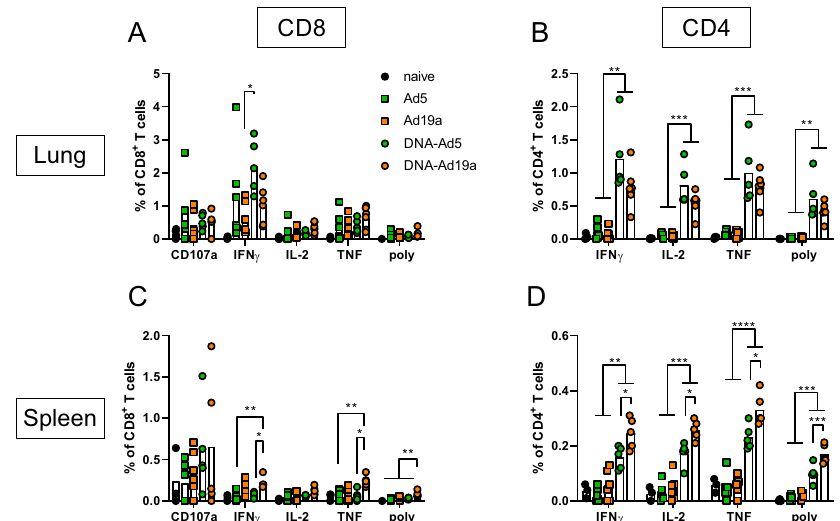
Fig. 4 Spike-speci fi c T cell responses after intranasal immunization with Ad5- or Ad19a-based viral vector vaccines. BALB/c mice were vaccinated according to Fig. 1A. Lung and spleen homogenates were restimulated with peptide pools covering major parts of S. The responding CD8 + ( A and C ) and CD4 + T cells ( B and D ) were identi fi ed by intracellular staining for accumulated cytokines or staining for CD107a as degranulation marker. The gating strategy is shown in Supplementary Fig. 3. Bars represent group means overlaid with individual data points; naïve n = 4 (exception: n = 3 in C and D ); DNA- Ad5 n = 5; other groups n = 6. Data were analysed by one-way ANOVA followed by Tukey ’ s multiple comparison test. Statistically signi fi cant differences are indicated only among the different vaccine groups; p values indicate signi fi cant differences (* p < 0.05; ** p < 0.005; *** p < 0.0005; **** p < 0.0001). poly; polyfunctional T cell population positive for all assessed markers.